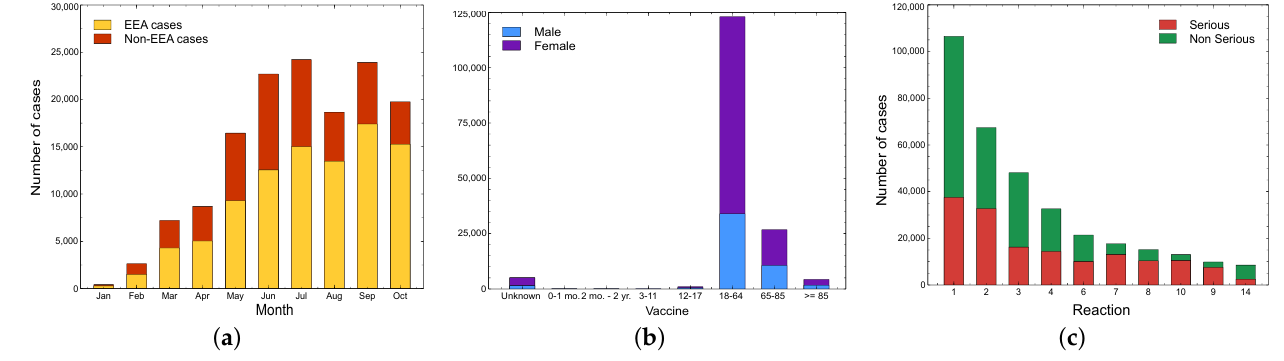
Figure 3. Main results of pharmacovigilance for Spikevax vaccine: number of reports received over time ( a ), and their distribution by age group and sex ( b ) and by seriousness ( c ).